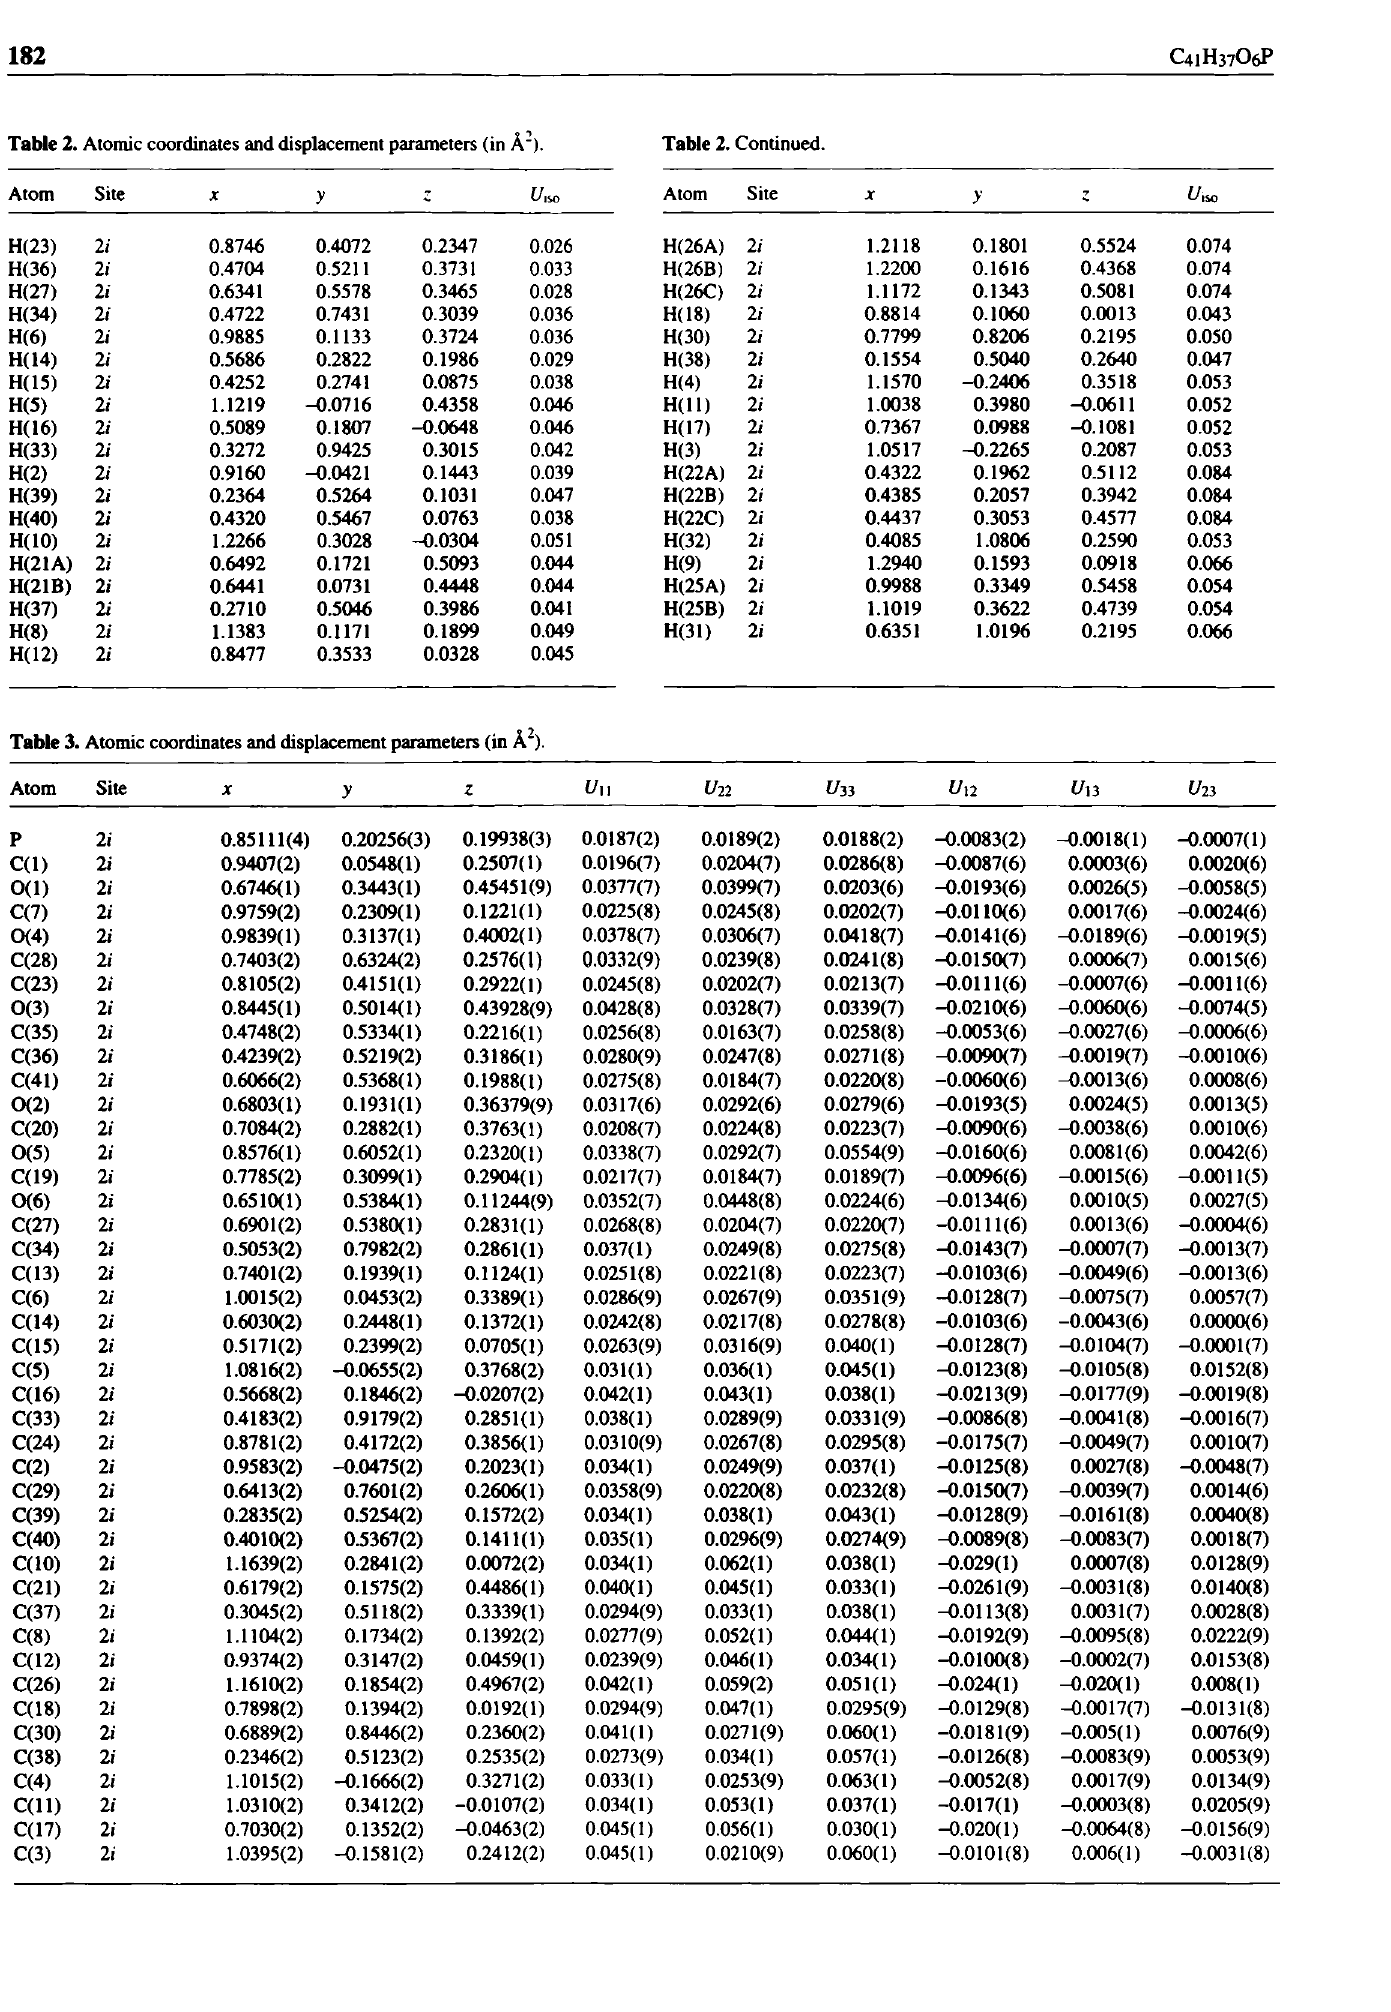
Table 2. Atomic coordinates and displacement parameters (in À : ).